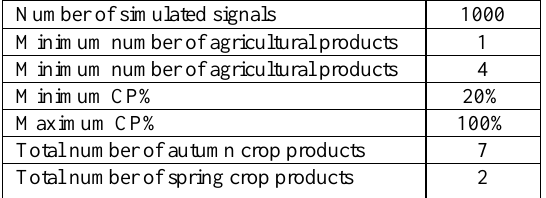
Table (1). Simulation specifications of the VI time series